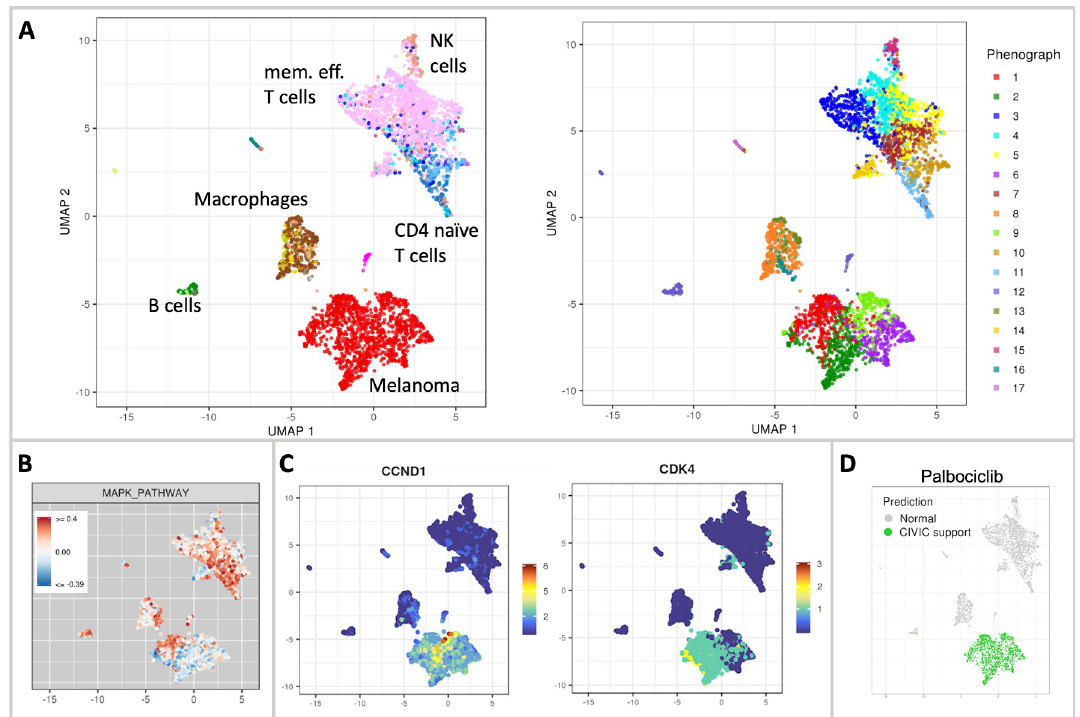
Fig 3. Sample composition and interpretation of a melanoma sample. In (A) the UMAP embedding is colored by cell type label (left) and cluster (right), with major cell type populations highlighted in the figure. For a complete overview of cell types, see Fig B in S2 Text. In (B), the enrichment of the MAPK pathway is exemplified. In (C), UMAPs showing the gene expression of CCND1 and CDK4 are shown as selected examples of individual gene expression plots. The UMAP in (D) shows the drug candidate identification result for the drug